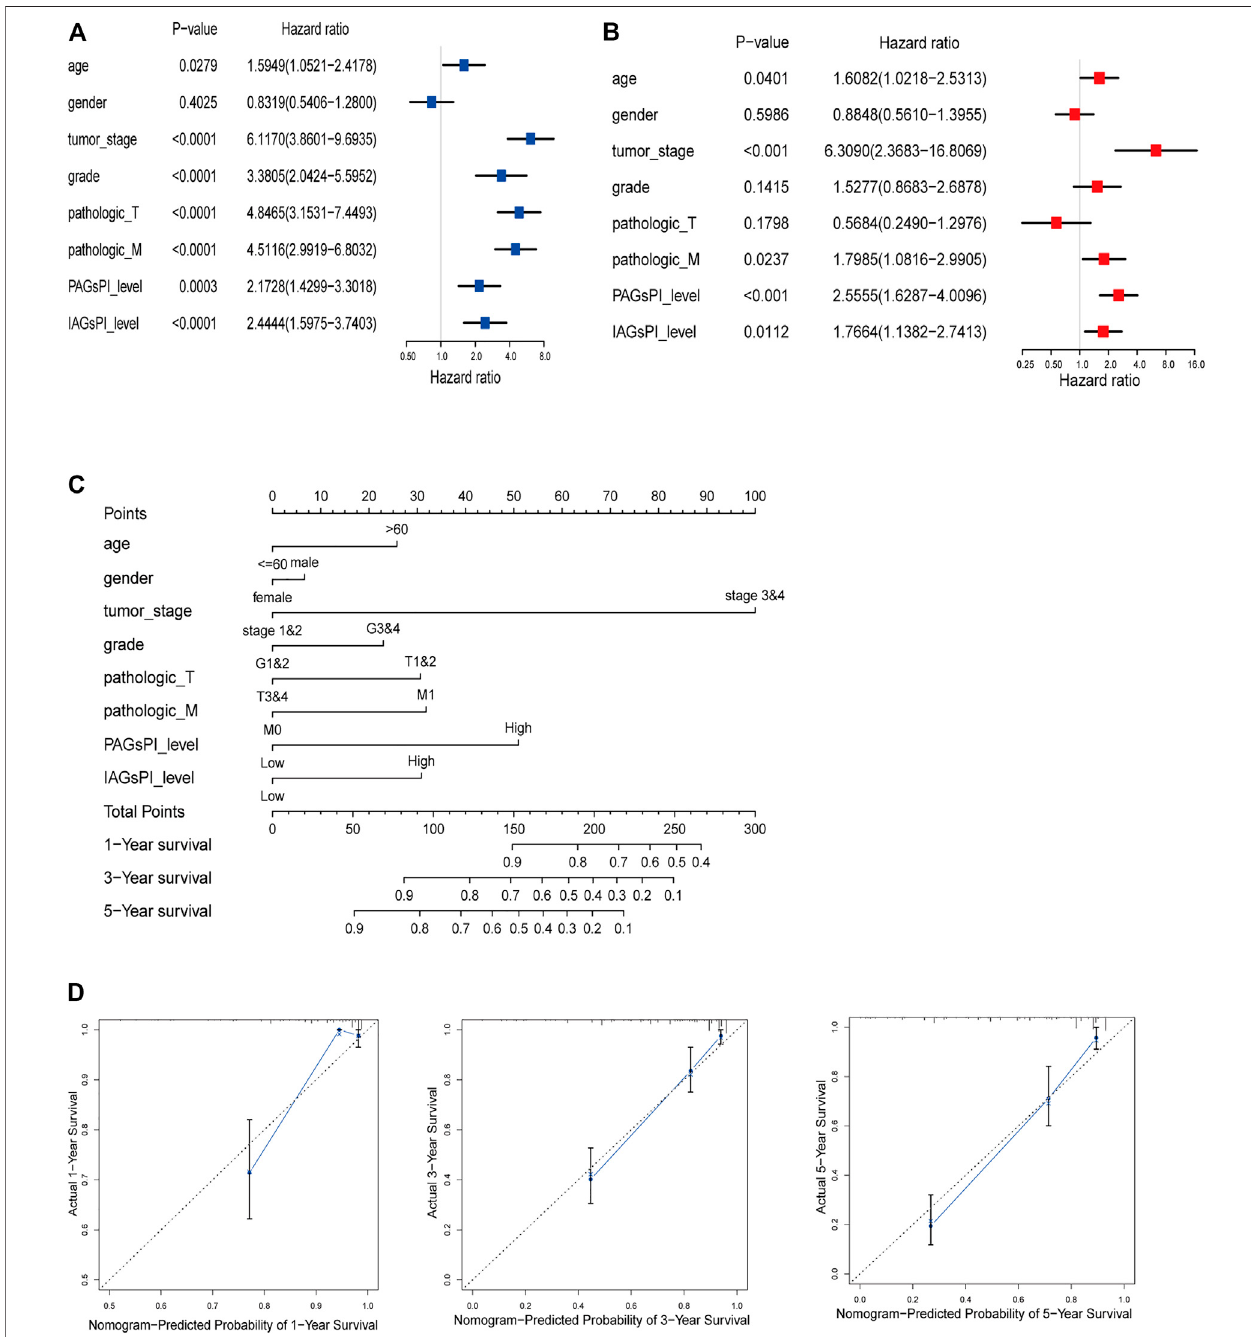
FIGURE7| Construction ofapredictive nomogram. (A,B) Univariateand multivariate Coxregressionanalysesresults ofage,gender,tumor stage, grade, Tstage, M stage, PAGsPI and IAGsPI. (C) Nomogram for predicting the prognosis of 1 year, 3 and 5 years. The higher the overall score, the worse the prognosis. (D) The calibration curves of 1-, 3- and 5-year prognostic prediction for the nomogram. The more the blue solid line and the black dotted line coincide, the more accurate the prediction was.